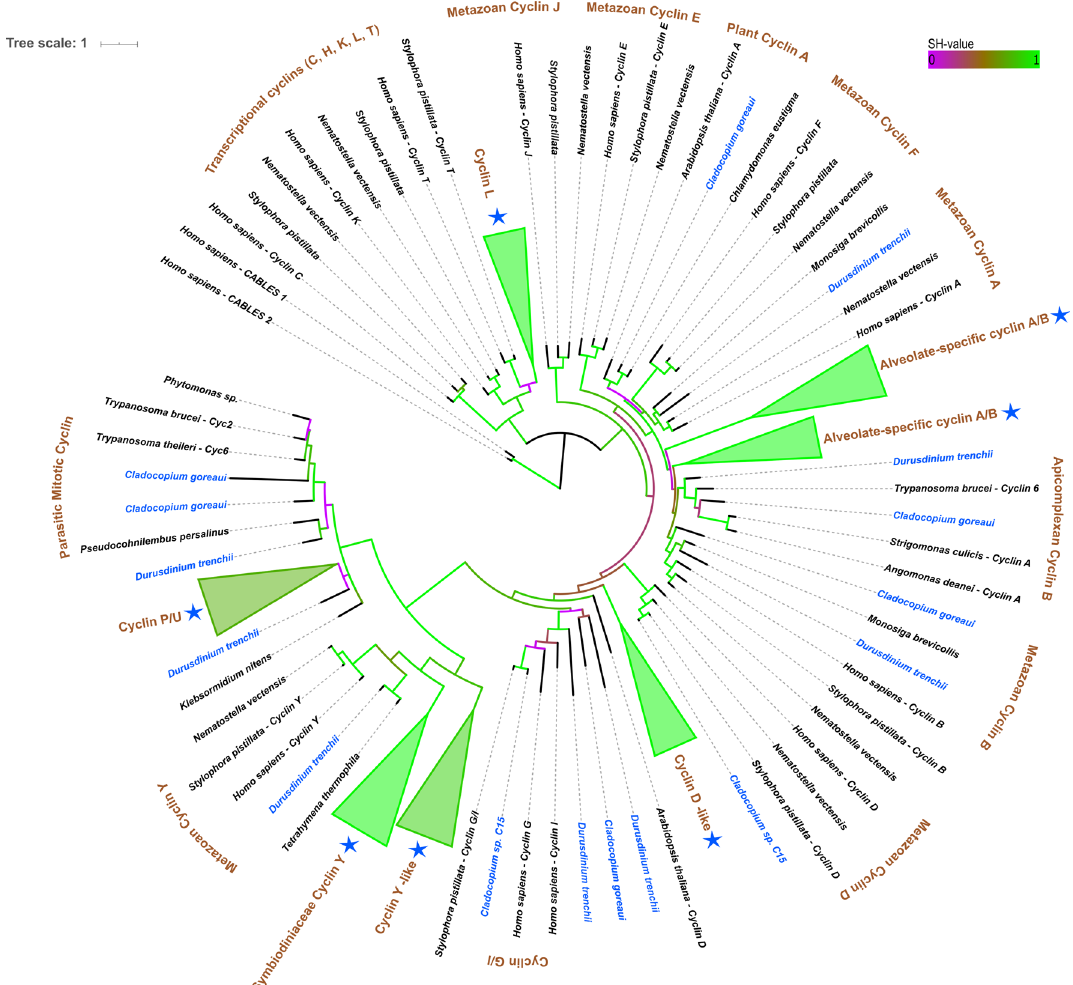
Figure 4. Collapsed phylogenetic tree of cyclins in the Symbiodiniaceae. Colour of branches corresponds to aLRT support (SH-value). Purple branches correspond to SH-values below 0.5, brown branches correspond to SH-values near 0.5, and green branches correspond to SH-values close to 1. Symbiodiniaceae species are written in blue, and blue stars depict collapsed branches containing Symbiodiniaceae species. The tree was made using PhyML(v3.1) 41 and visualised using the Interactive Tree of Life software (v.5.6.3) 44